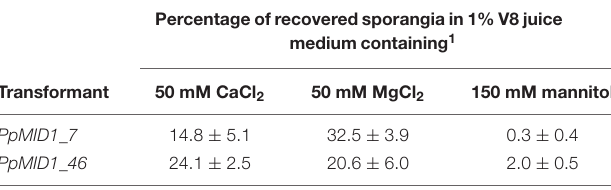
TABLE 2 | Morphology of sporangia produced by PpMID1- silenced transformants is reversed with the addition of calcium or magnesium ions. Percentageofrecoveredsporangiain1%V8juice mediumcontaining 1